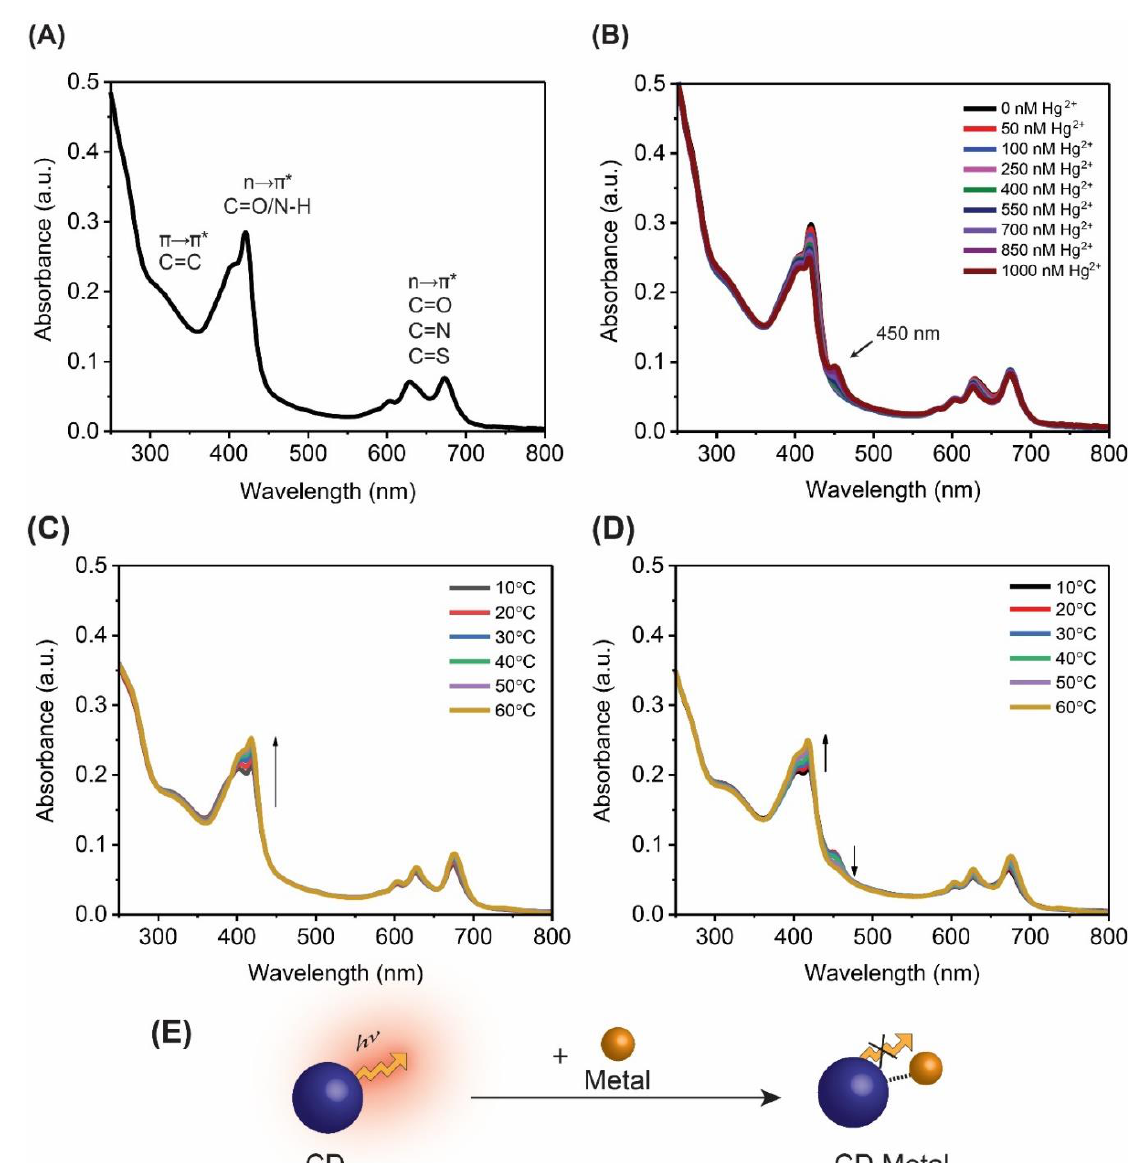
Figure 2. Absorbance spectra for FG-CDs ( A ) alone, ( B ) showing a new peak at ~450 nm in the presence of Hg 2+ . Absorbance spectra of FG-CDs showing changes as a function of increasing temperatures ( C ) with 0 nM of Hg 2+ and ( D ) with 1000 nM of Hg 2+ . ( E ) Graphical illustration of CD fluorescence quenching upon binding to a metallic cation.